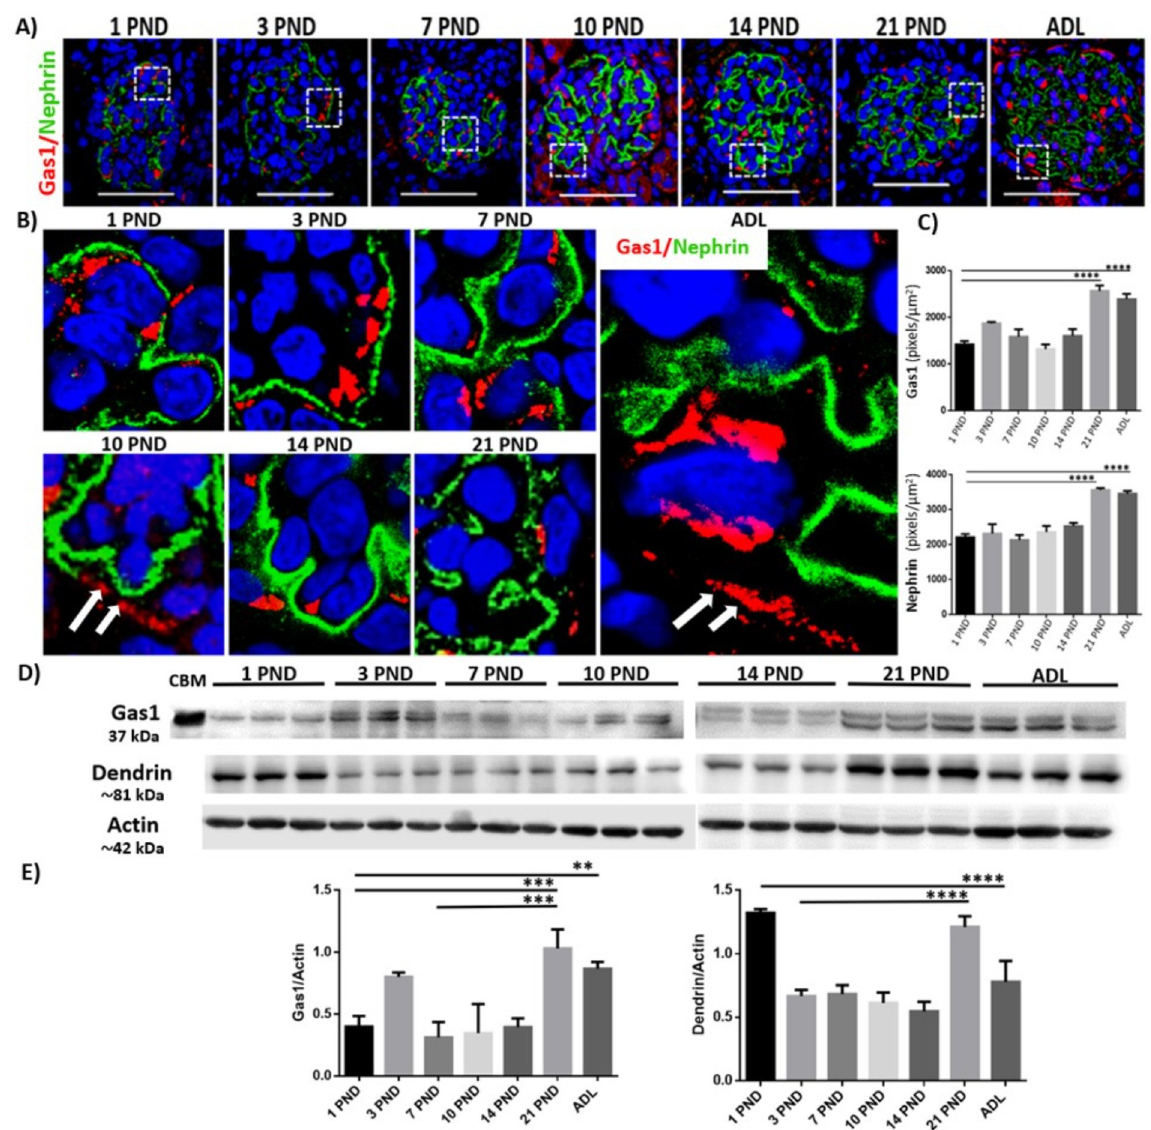
Fig 2. Gas1 is expressed in the glomerulus during postnatal renal development and in adulthood in the rat. A) Immunofluorescence of the general expression pattern of Gas1 and Nephrin on the different postnatal days (PND) evaluated. Gas1 is expressed in the glomerulus and Bowman’s capsule, and its expression increases as the kidney matures. B) magnification of the boxes in A, Gas1 is expressed intraglomerularly and in Bowman’s capsule (BC) (white arrows). C) Semi-quantitative analysis of Gas1 and Nephrin in the glomerulus, a significant increase in the expression of both proteins is observed during renal maturation (PND 21 and ADL). D and E) analysis of the expression of Gas1 and Dendrin by Western blot in an enriched sample of glomeruli. We used a cerebellum sample (CBM) as a positive control for Gas1 expression. Both bands of Gas1 were considered for the densitometric analysis. Each PND analyzed is expressed as the relative density of a group of 20 (younger ages) and 8 (21 PND and adult) rats normalized with actin as loading control. Gas1 (red), Nephrin (green) and nuclei with DAPI (blue). The white squares represent the magnification of specific areas in the glomerulus. Scale bars = 50 μ m. Values are means ± standard deviation (SD). One- way ANOVA. * p < 0.05, **** p < 0.0001. Immunofluorescence experiments were performed in kidney sections. A representative experiment is shown (n =